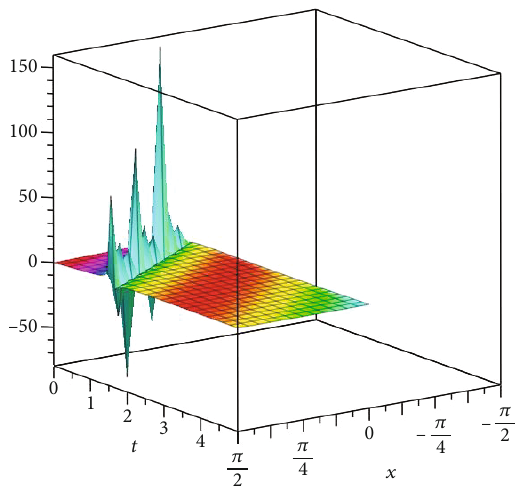
ð x , y , t Þ given by 6